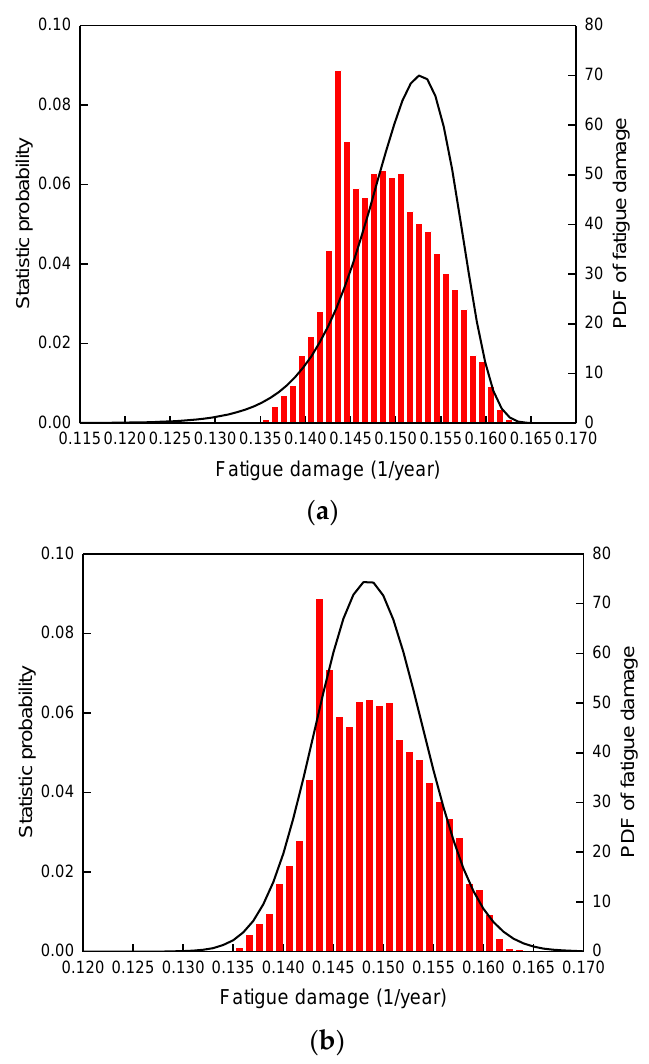
Figure 10. PDF of fatigue damage of HW weld. ( a ) Weibull distribution. ( b ) Lognormal distribution.